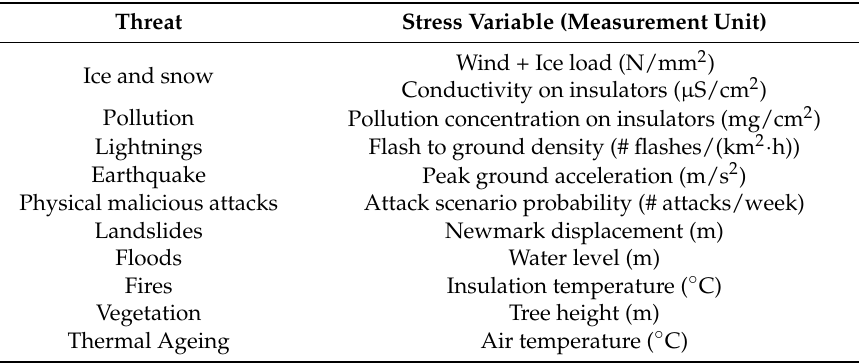
Table 1. Stress variables adopted for the threats under